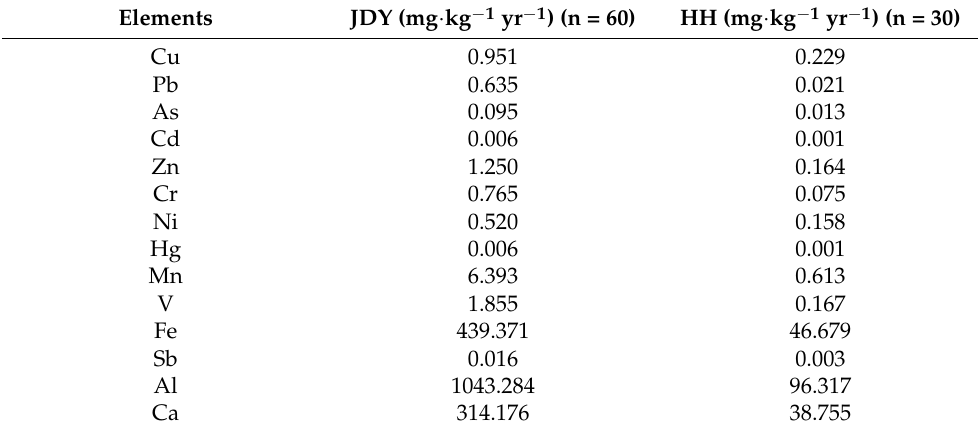
Table 1. Summary of the accumulation rate of HMs for two core samples from JDY and HH peatlands in Altay Mountains.